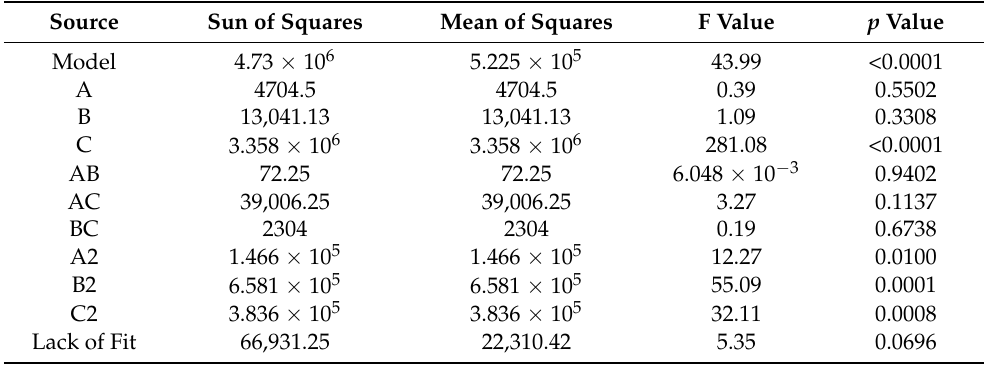
Table 10. Variance analysis of the SPRC impact-life response